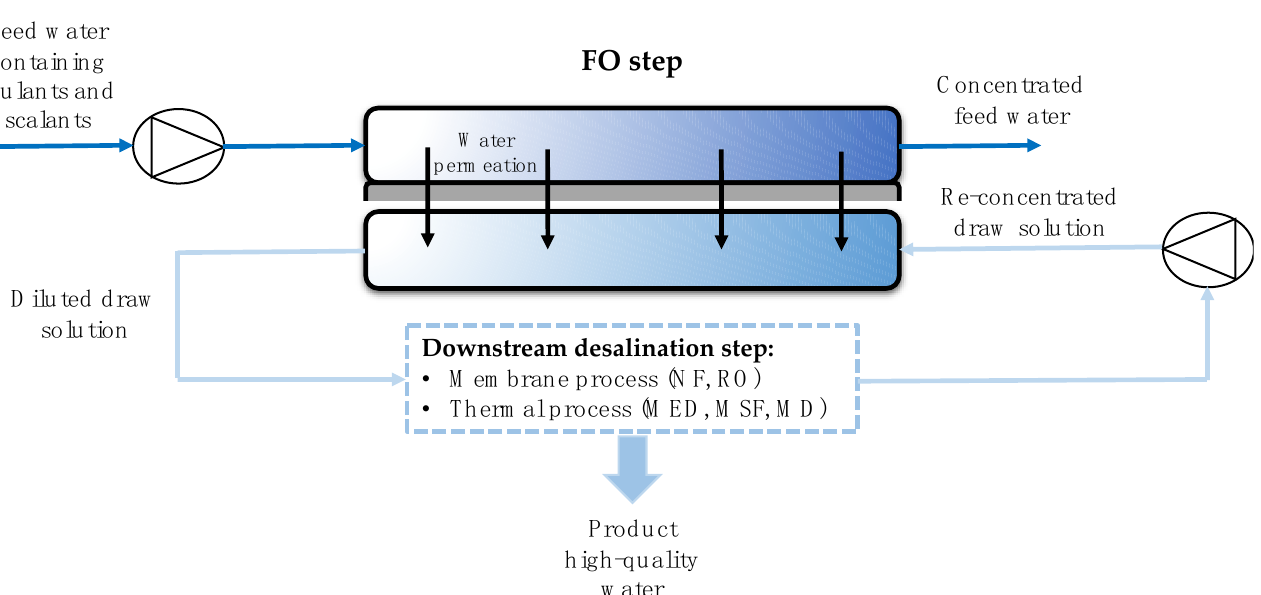
Figure 9. Schematic view of FO pretreatment in hybrid systems for desalination. Based on Tiraferri [102].